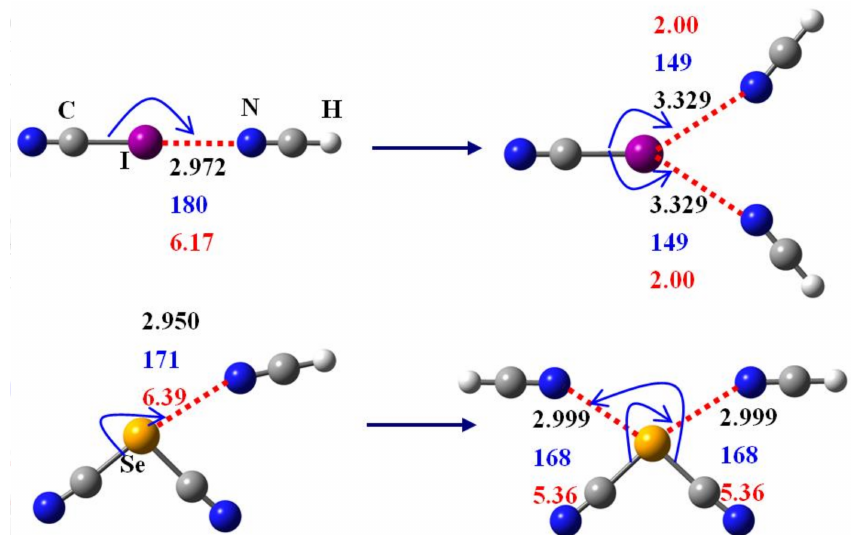
Figure 2. Bond lengths (black numbers, in Å), bond angles (blue numbers, in ◦ ) and bond strengths (red numbers, in kcal/mol) of the noncovalent bonds in the complexes NCI ··· NCH, NCI ··· (NCH) 2 , (NC) 2 Se ··· NCH and (NC) 2 Se ··· (NCH) 2